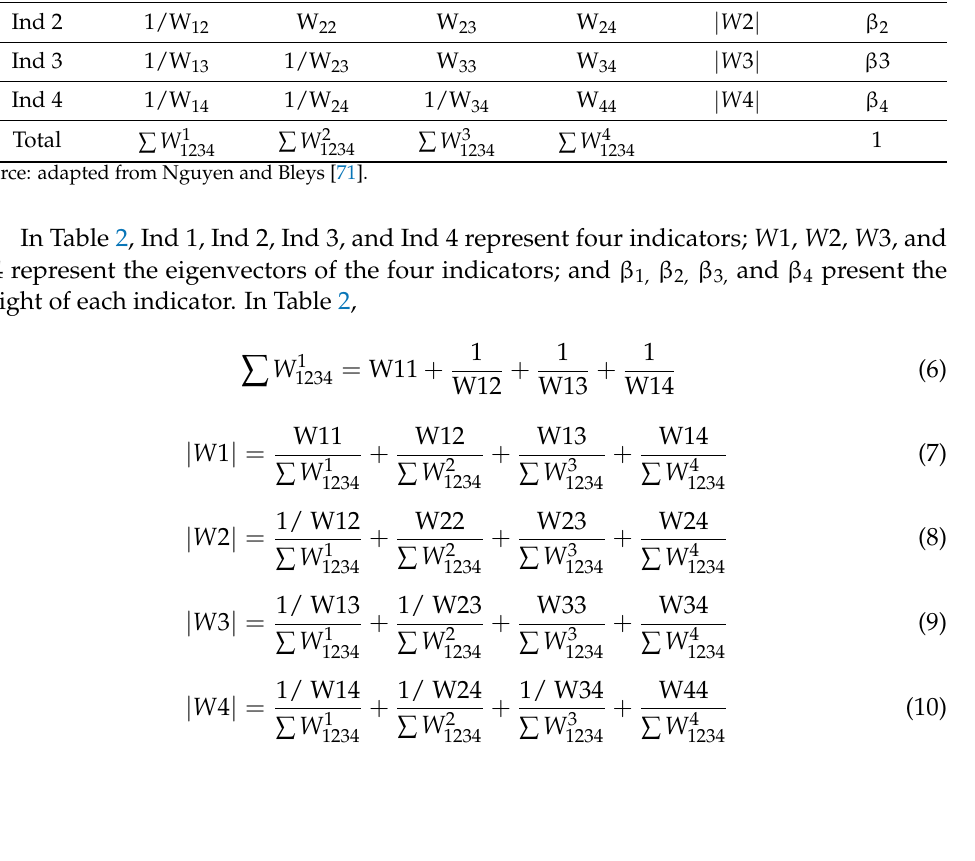
Table 1. The fundamental scale of numbers used in AHP method. Intensity of Importance Definition Explanation Two activities contribute 1 Equal importance equally to the objective Experience and judgment Moderate importance of one 3 slightly favor one activity over over another another Experience and judgment strongly favor one activity 5 Essential or strong importance over another An activity is strongly 7 Very strong importance favored, and its dominance demonstrated in practice The evidence favoring one activity over another is of tile 9 Extreme importance highest possible order of affirmation 2, 4, 6, 8